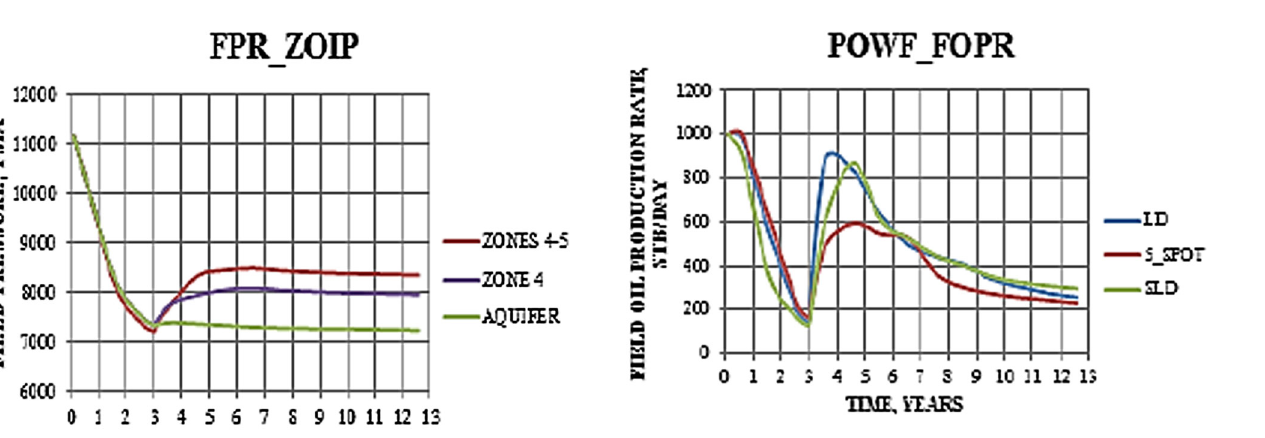
Fig. 18 Plot of the production rate of the field with time for different PoWF scenarios